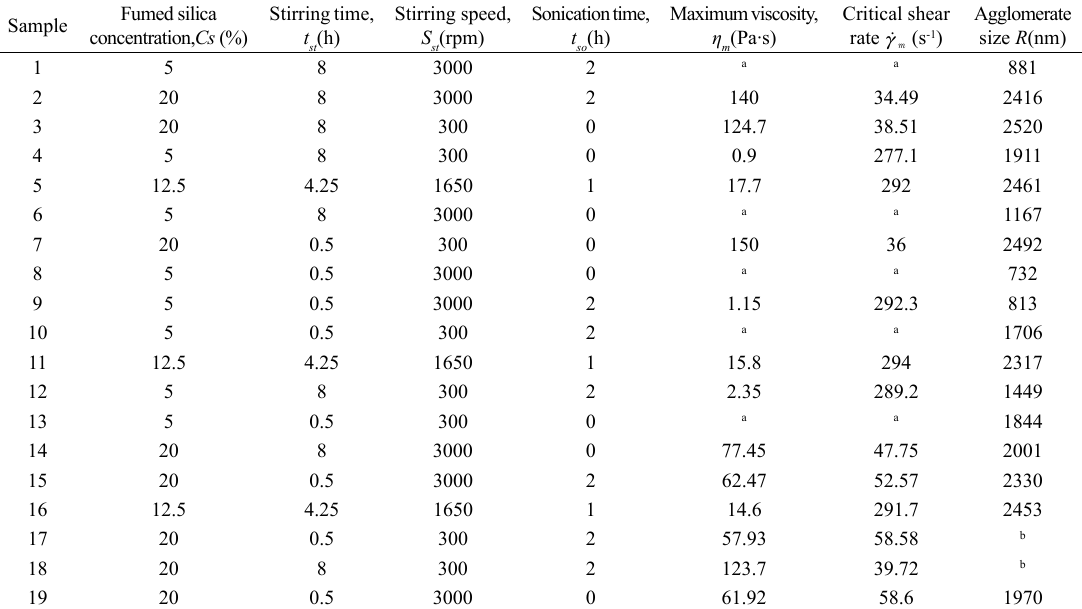
Table 3. Experimental design matrix with factors, their levels, and response variable values Sample